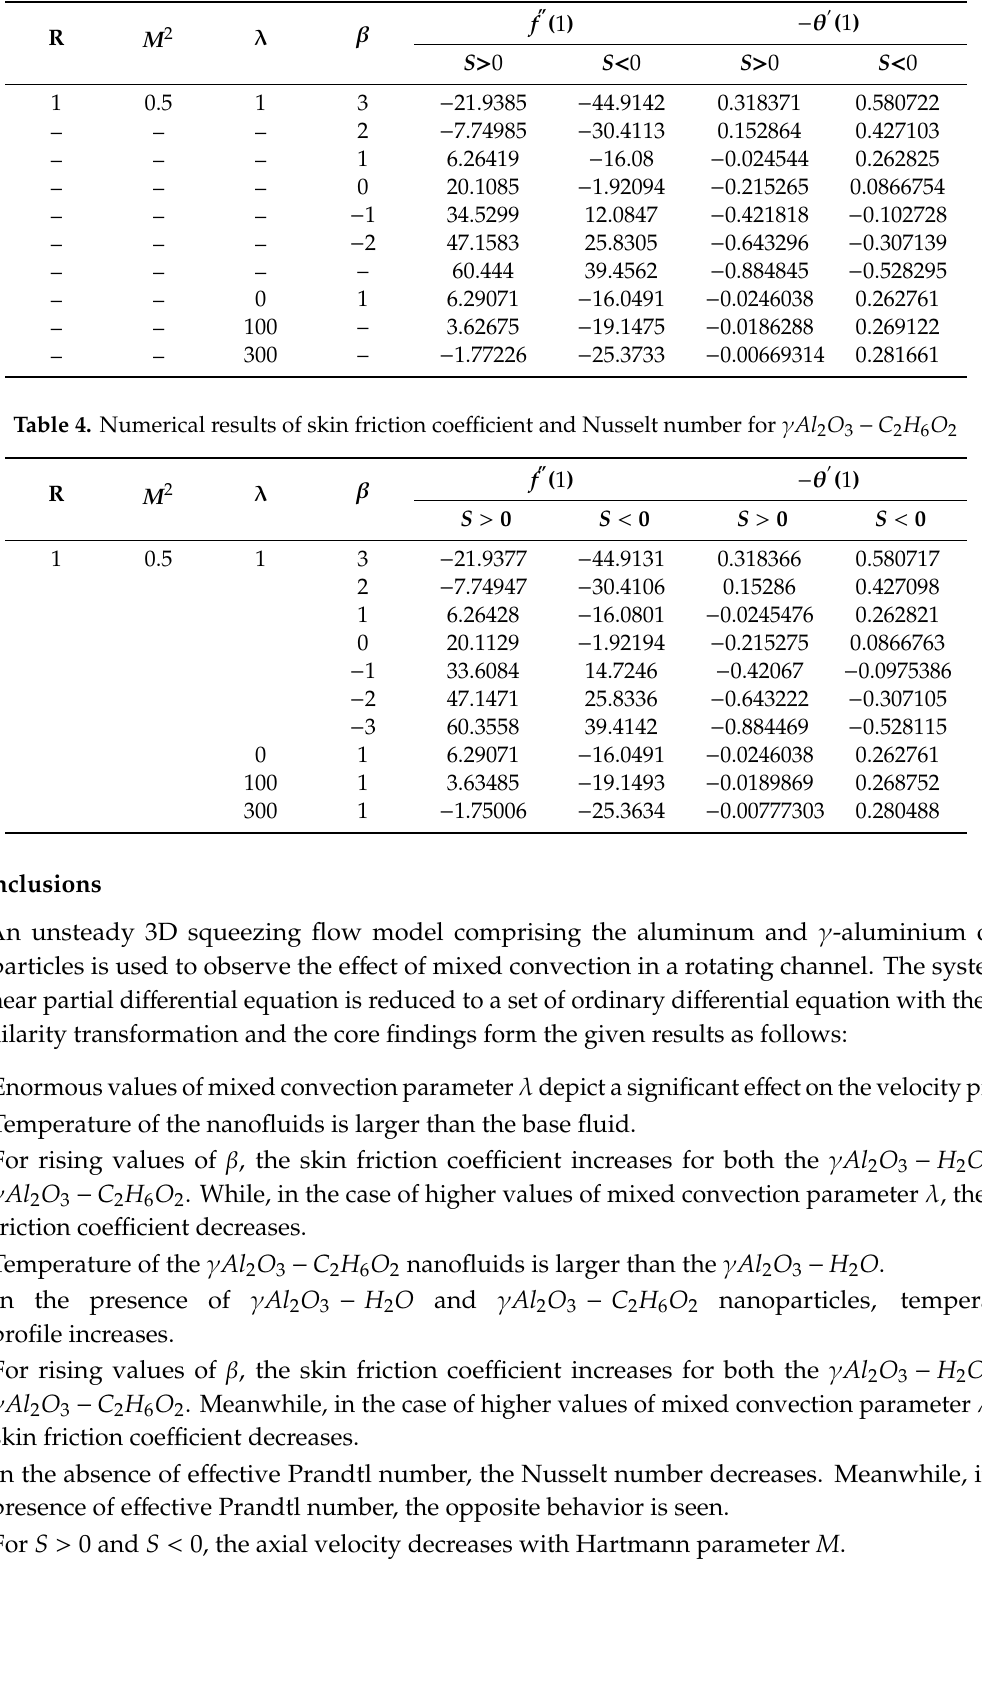
Table 3. Numerical results of skin friction coe ffi cient and Nusselt number for γ Al 2 O 3 − H 2 O R M 2 λ β